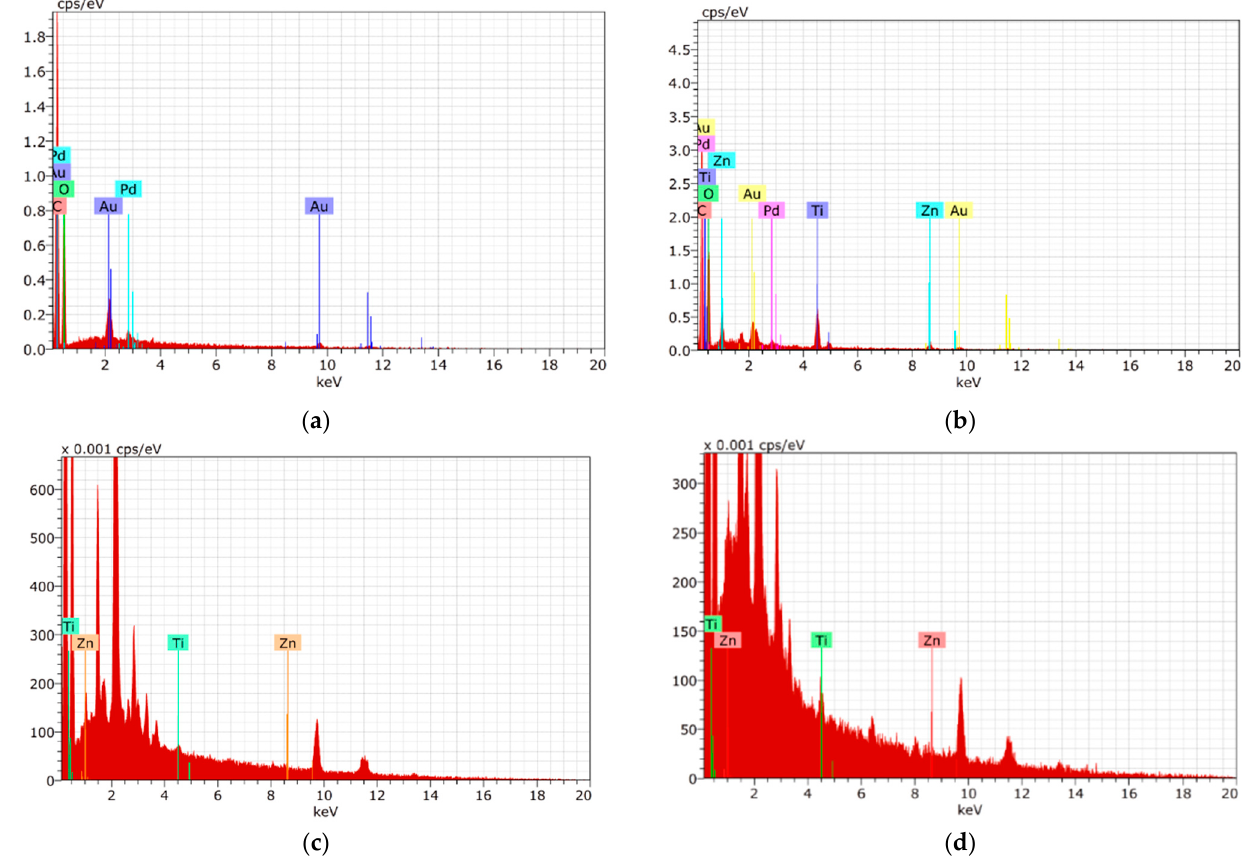
Figure 2. EDX spectra of ( a ) unmodified, ( b ) modified before washing, ( c ) modified after 15 washings and ( d ) modified after 30 washings cotton terry towels.